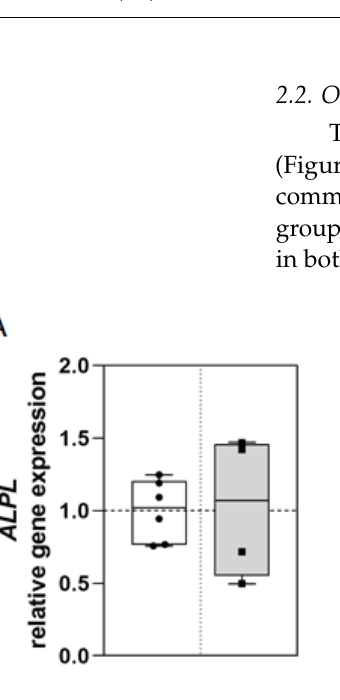
Figure 3. Gene expression in osteoblasts. Osteoblasts of both patient groups were cultured for 14 days (group A: n = 6; group C: n = 4) before RNA isolation and reverse transcription. Quantitative real-time PCR revealed the gene expressions of ALPL ( A ), RUNX2 ( B ) and BGLAP ( C ). Gene expression was normalized to GAPDH expression and analyzed using the CT method. Data are provided relative to group A control and as median with interquartile range and min/max values; statistical analyses were performed using ANOVA and Tukey post-hoc test.